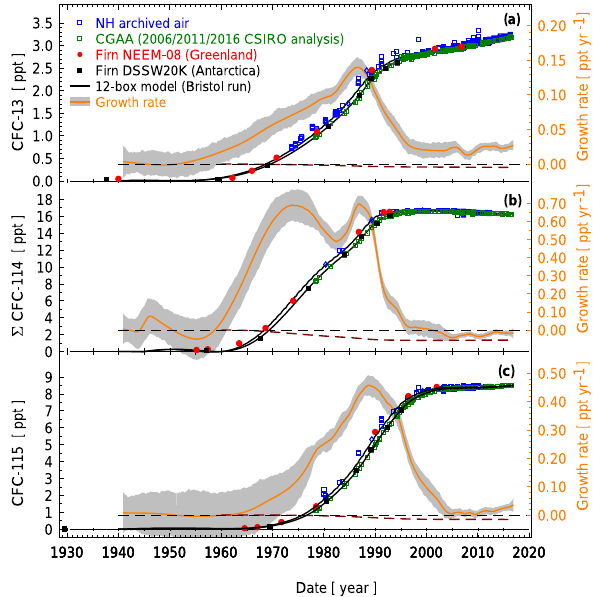
Figure 3. Measurements of the chlorofluorocarbons CFC-13 (a) , (cid:54) CFC-114 (b) , and CFC-115 (c) from archived air samples and firn. Firn measurements are plotted against either effective or mean ages of the samples (see text). In situ measurement results from the AGAGE stations are not plotted for clarity. The inversion results are given for the Northern Hemisphere (upper solid lines) and Southern Hemisphere (lower solid lines). Growth rates (shown in orange us- ing the right axes) are globally averaged from model results. Note that zero growth, shown as dashed black lines, is offset relative to the left axes. With focus on the recent part of the record the growth rates deviate significantly from the growth rates that would be ob- tained if zero emissions were assumed (shown as maroon dashed lines, calculated by dividing the global mole fraction by the life-